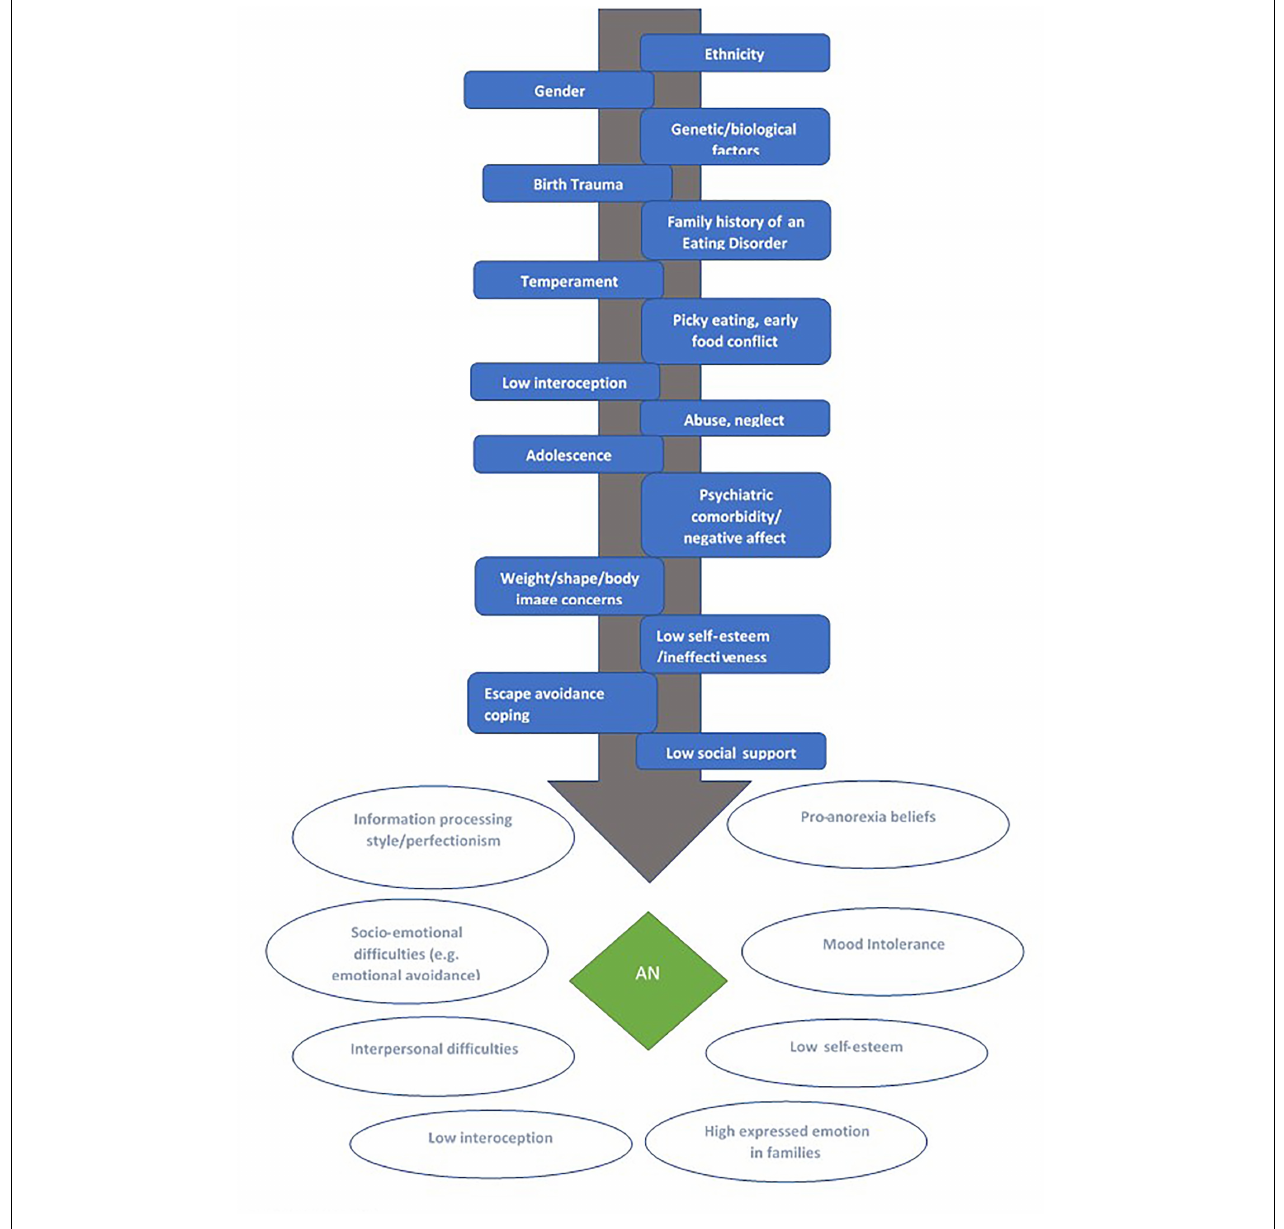
FIGURE 1 | Summary of risk and maintenance factors for Anorexia Nervosa, adapted form several sources (Stice, 2002; Jacobi et al., 2004; Striegel-Moore and Bulik, 2007; Treasure and Schmidt, 2013). Putative risk factors are depicted and maintenance factors depicted